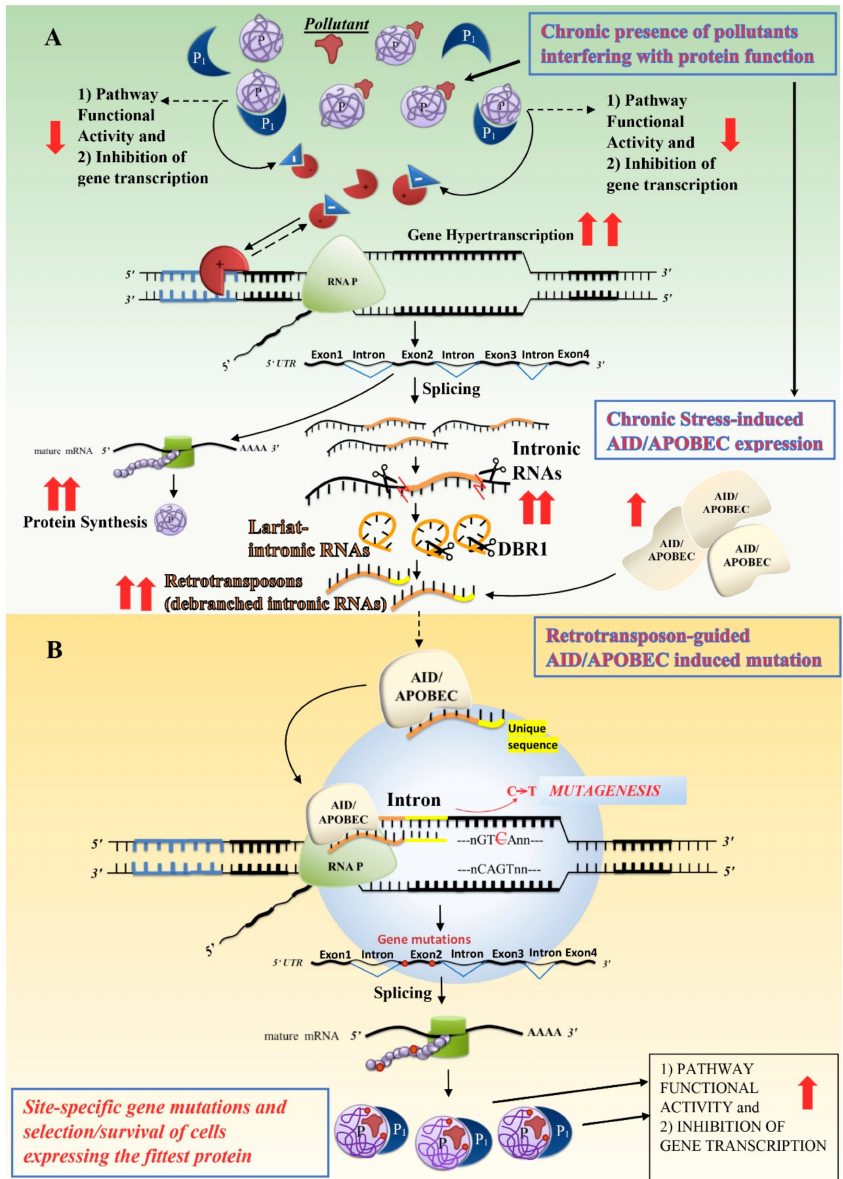
Figure 3. Putative cellular mechanism of eukaryotic genome editing in response to chronic stress conditions. Sequential steps of gene hyper-transcription ( A ) and gene mutagenesis ( B ) induced by a pollutant binding to a protein. An example depicting chronic stress-induced site-specific mutagenesis mediated by APOBEC enzymes. (for reference, see the text). RNA P: RNA polymerase; P / P1: protein / protein 1; : transcription factor; : repressor; : increase; : decrease; DBR1: lariat debranching